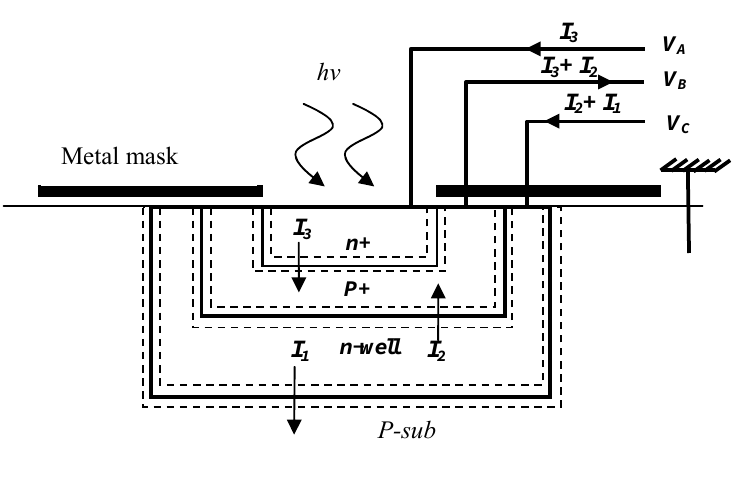
Figure 1. Cross-section view of